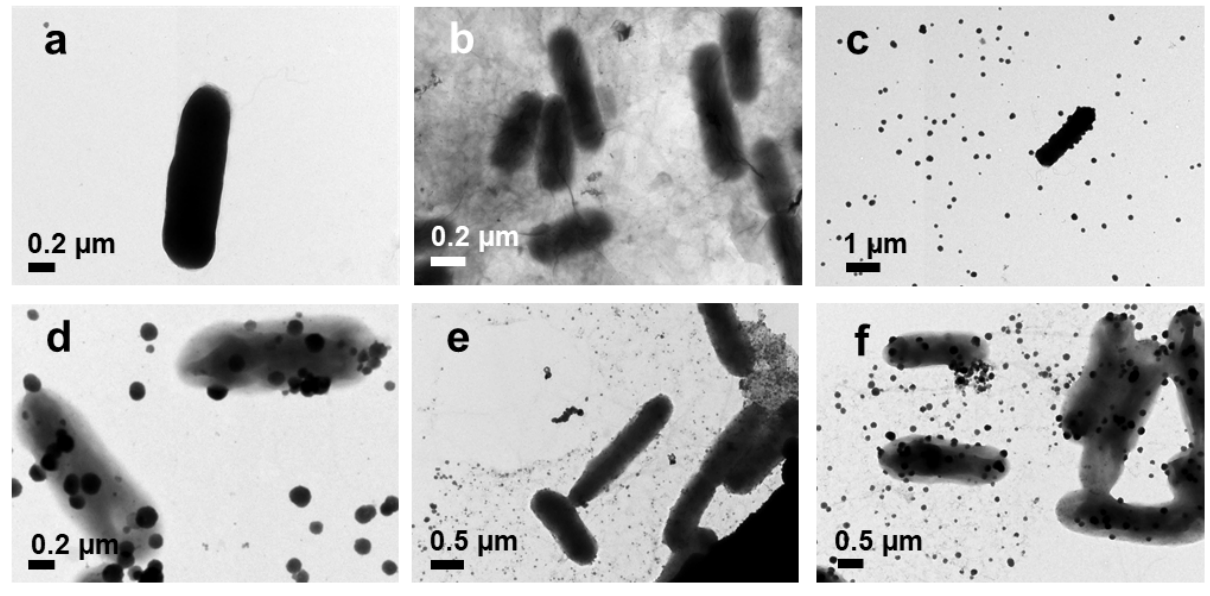
Figure 11. TEM images of E. coli before ( a ) and after treatment with GO ( b ), Ag NPs ( c ), Ag NPrsms ( d ), GO–Ag NPs ( e ), and GO–Ag NPrsms ( f ).